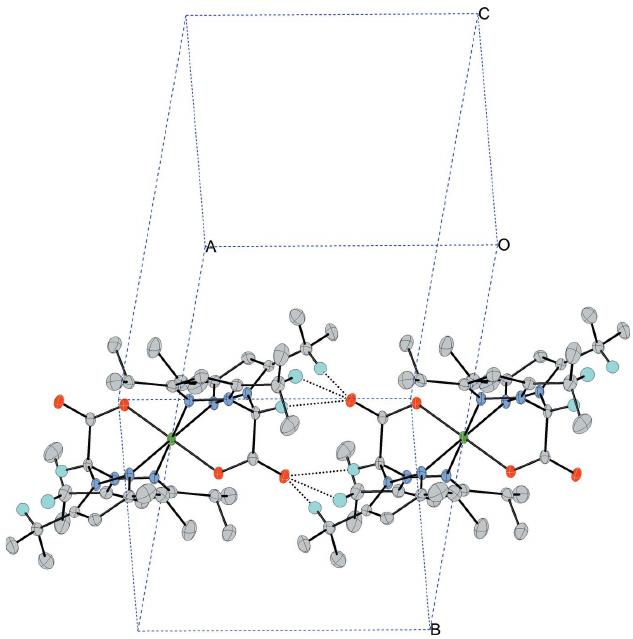
Figure 2 A partial unit-cell packing diagram, showing the weak C—H (cid:4)(cid:4)(cid:4) O intermolecular interactions (dashed lines). For clarity, only H atoms involved in the C—H (cid:4)(cid:4)(cid:4) O interactions between adjacent molecules have been